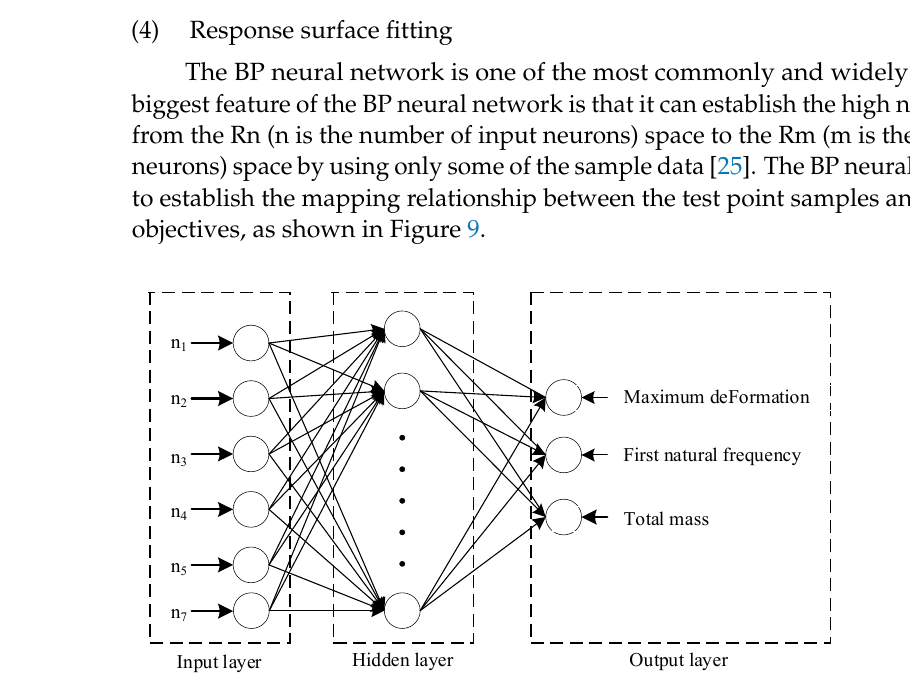
Figure 9. Mapping relationship between sample data and optimization objective.